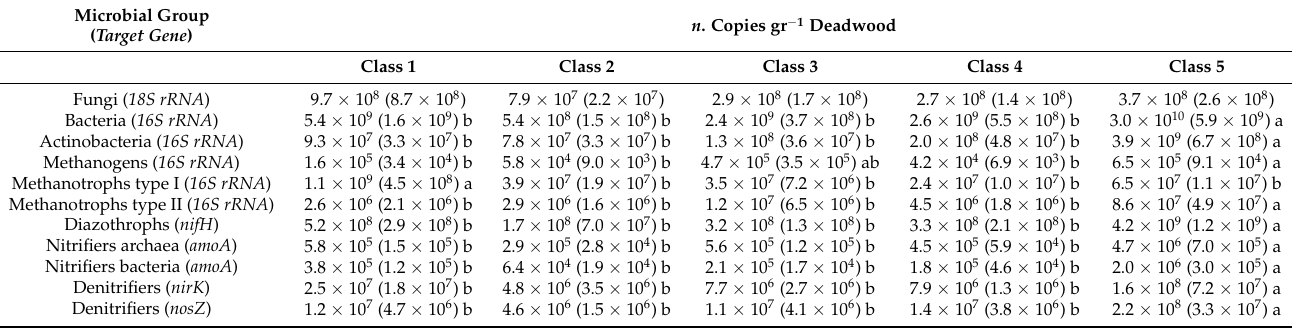
Table 3. Real time PCR results for quantification of the various microbial groups in DNA extracted from the black pine deadwood cores of the different decay classes. Values are means with standard error in parentheses. Different letters in a row indicate significant difference at p < 0.05 (LSD test).